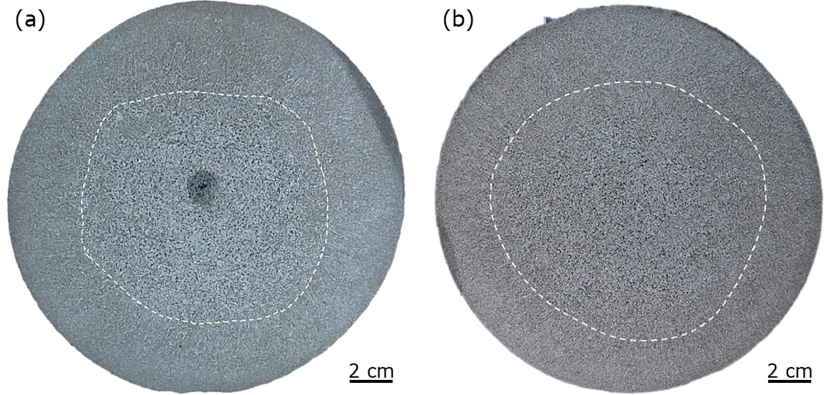
Figure 3. Macrostructure on cross section of low-alloy steel S4 (No. 11) round billet ( a ) without PMO and ( b ) with PMO.